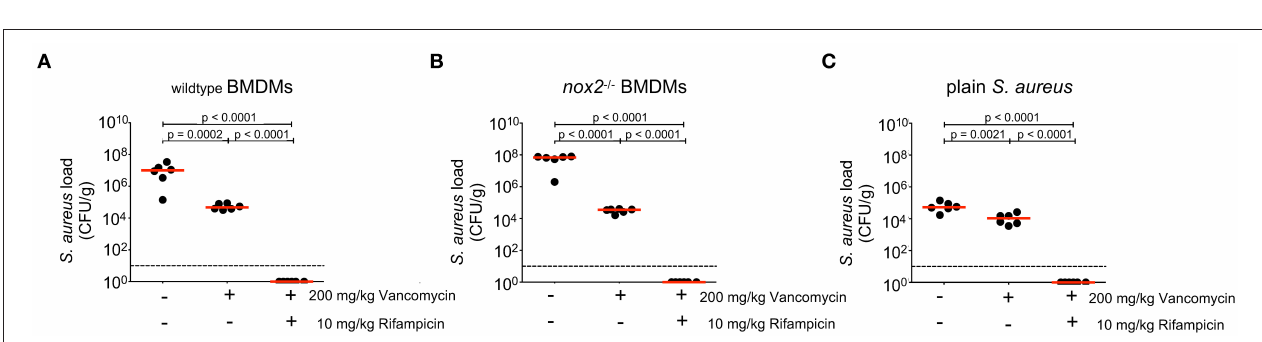
FIGURE 3 | values for each organ in CFU/g from two independent experiments. Red line indicates median, dashed line represents limit of detection. Student’s t -test was performed on log-transformed values. CFU numbers were analyzed. in kidneys (A) 24h (wt: n = 11; nox2 − / − : n = 14; plain S. aureus : n = 7) and (B) 7 days (wildtype: n = 12; nox2 − / − : n = 13; plain S. aureus : n = 8). (C) Percentage of mice without detectable CFU in kidneys for indicated timepoints. CFU numbers in spleen (D) 24h and (E) 72h (wildtype: n = 17; nox2 − / − : n = 15; plain S. aureus : n = 17) p.i. CFU numbers in liver (F) 24h and (G) 72h p.i.. (H) Contingency table for presence or absence of visible abscesses in liver 72h post infection analyzed by Fisher‘s exact test. (I) Representative pictures from livers 72h post infection with micrographs from respective Hematoxylin-Eosin staining on formalin fixed tissue. Black arrows indicate abscesses. Scale bar represents 500 µ m in upper and 100 µ m in lower micrographs, respectively. Rectangular zone in upper pictures indicates position of bottom pictures. NOX, NADPH Oxidas; ROS, reactive oxygen species; PMA, phorbol 12-myristate 13-acetate; DPI, diphenyleniodonium; MOI, multiplicity of infection; BMDMs, bone marrow derived macrophages; SD, standard deviation; TLR2, Toll-like receptor 2; NMS, normal mouse serum; p.i., post infection; CFU, colony forming unit; i.v., intravenous; s.c., subcutaneous.